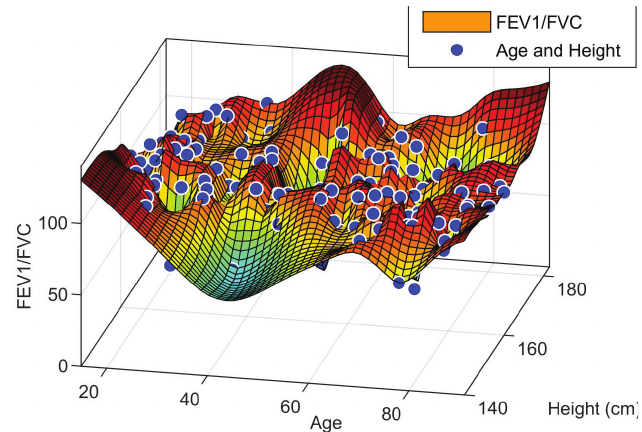
Figure 1. Surface plots of FEV1/FVCversus height and weight variables